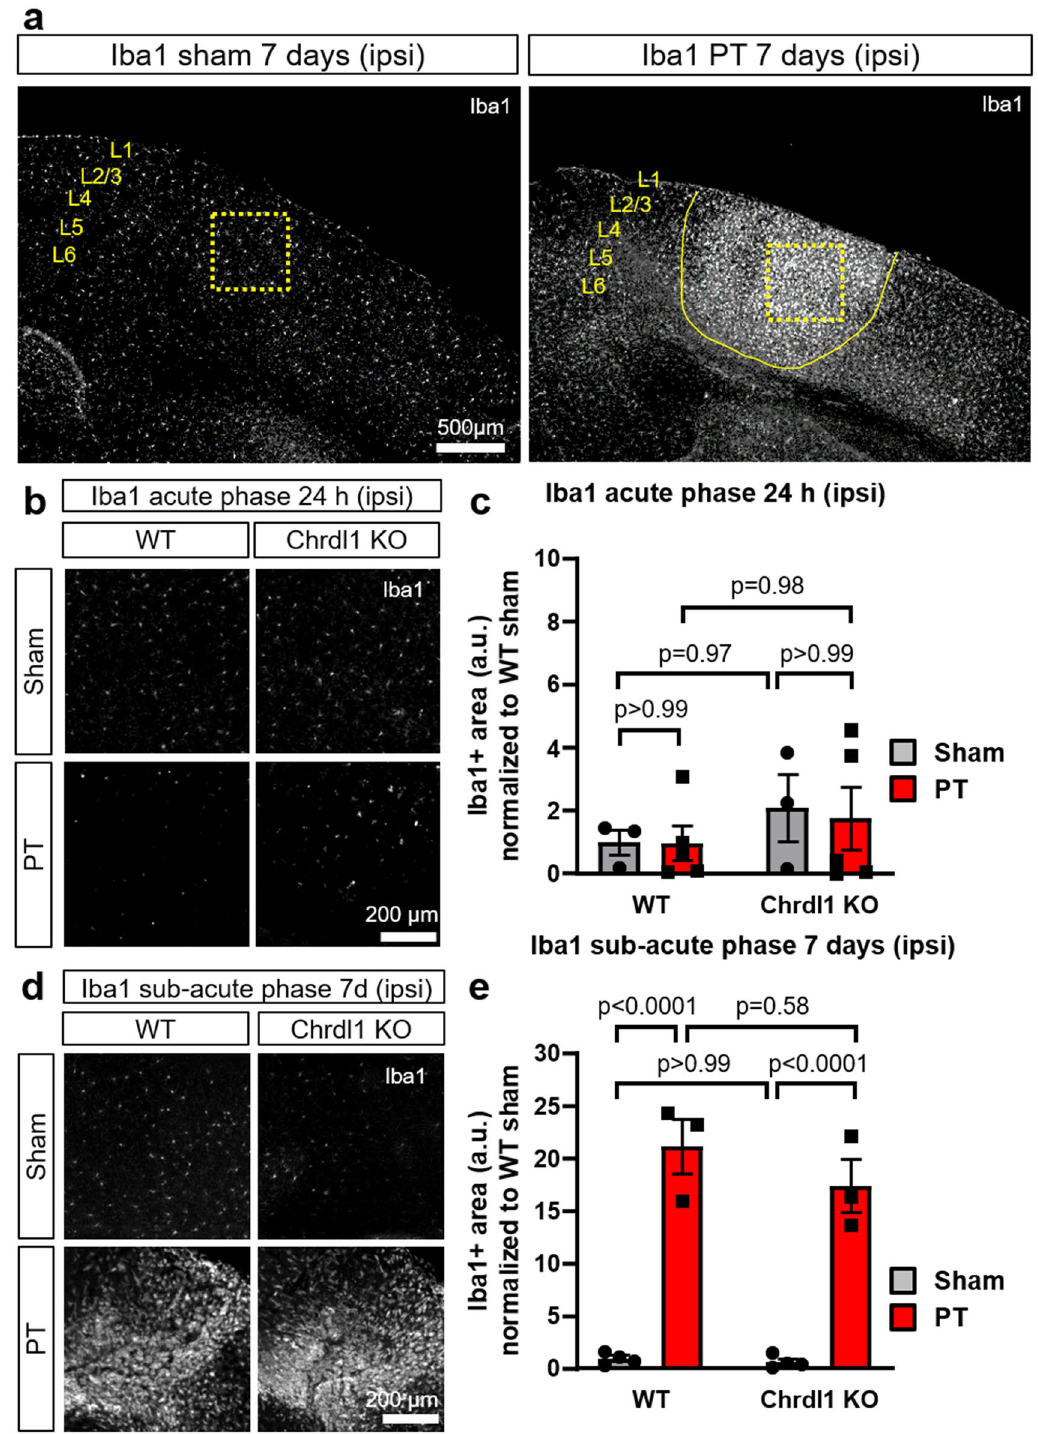
Figure 4. Absence of Chrdl1 does not affect the microglia response after PT injury. ( a ) Representative image of the upper layers of the visual cortex of a WT mouse 7 days after sham surgery or PT for Iba1 protein staining. The area in a dashed box is the region where analysis was performed. Core of the ischemic injury is delineated by the solid yellow line. Scale bar 500 µm. ( b ) Example images of the injury core of WT and Chrdl1 KO mice 24 h after PT or sham surgery immunostained for Iba1. ( c ) Quantification of Iba1 + stained area normalized to WT sham. WT sham N = 3, WT PT N = 5, Chrdl1 KO sham N = 3 and Chrdl1 KO PT N = 5 mice. ( d , e ) Same as ( a , b ) 7 days after PT or sham surgery immunostained for Iba1. WT sham N = 4, WT PT N = 3, Chrdl1 KO sham N = 4 and Chrdl1 KO PT N = 3 mice. Statistics by two-way ANOVA. Scale bar 200